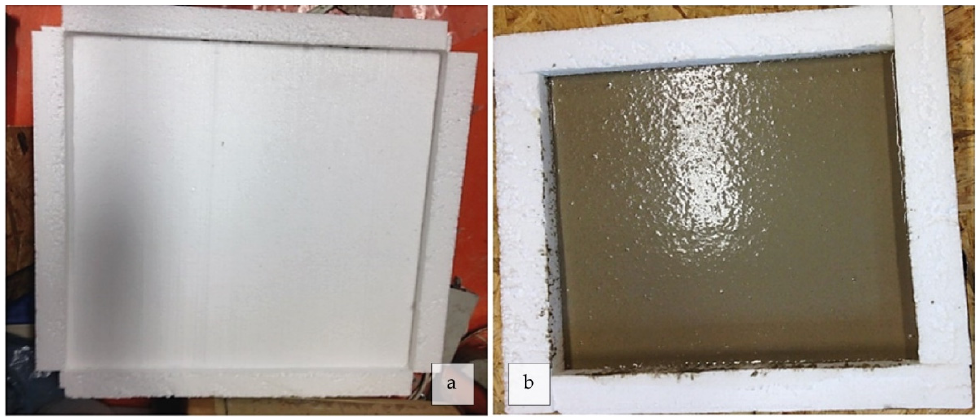
Figure 2. Preparation of three ( a ) polystyrene boards (500 × 500 mm) for testing the fire resistance: ( b ) the GF (300 × 300 mm) was coated on them with different thicknesses (20, 15, 10 mm). ( b ) the GF (300 × 300 mm 2 ) was coated on them with different thicknesses (20, 15, 10